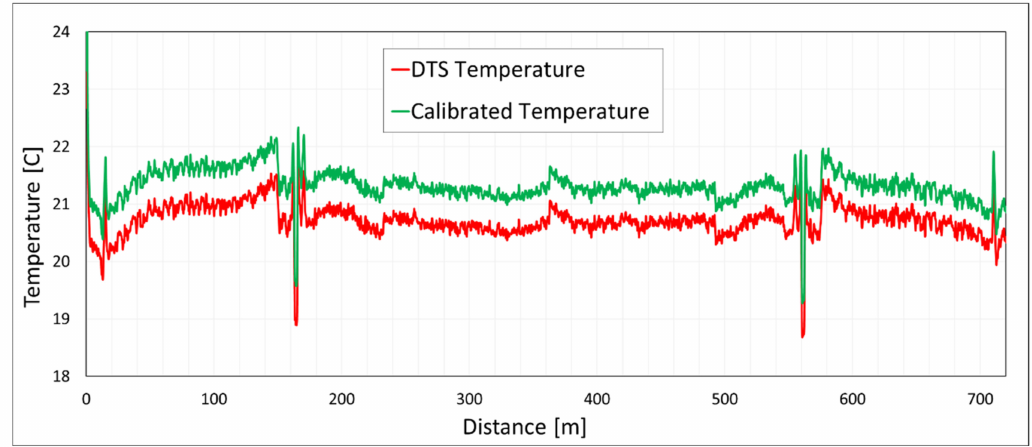
Figure 5. Temperature measurement with a duplexed single-ended approach and calibration based on two reference points for each side (four reference points in